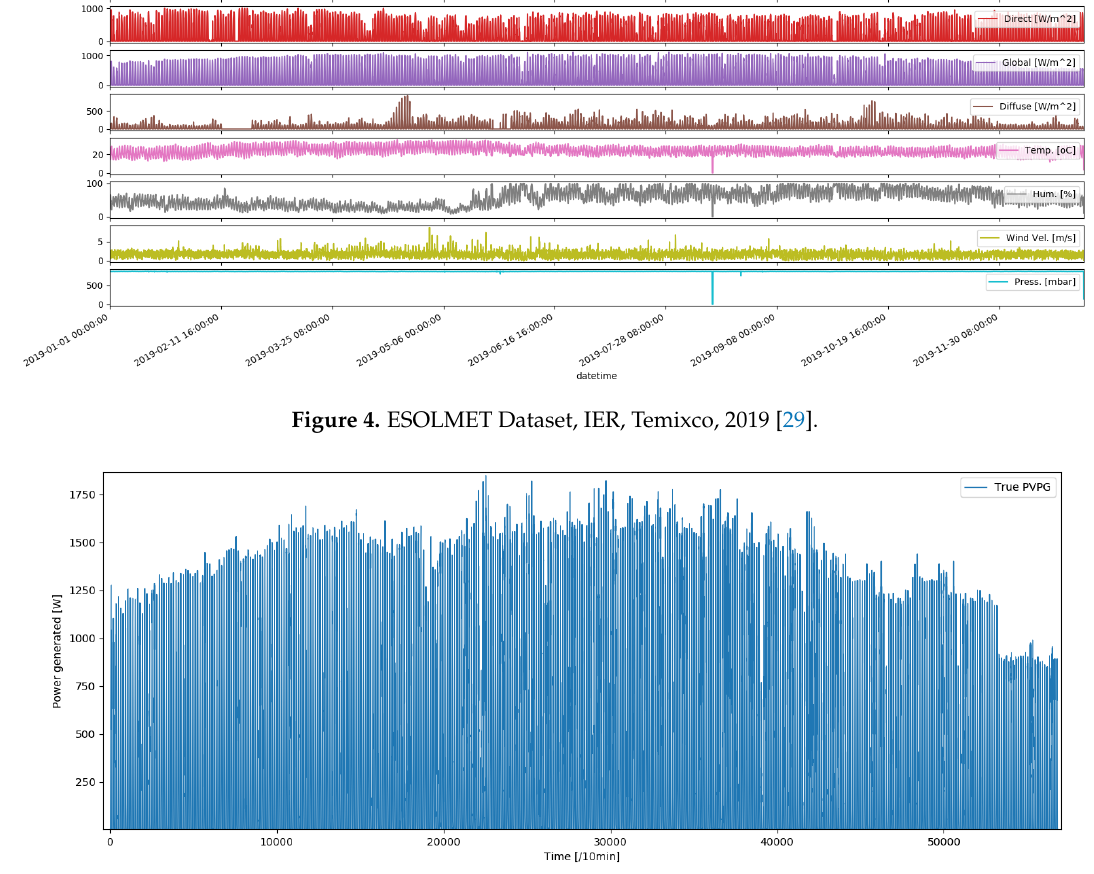
Figure 5. PV Generation in Temixco during